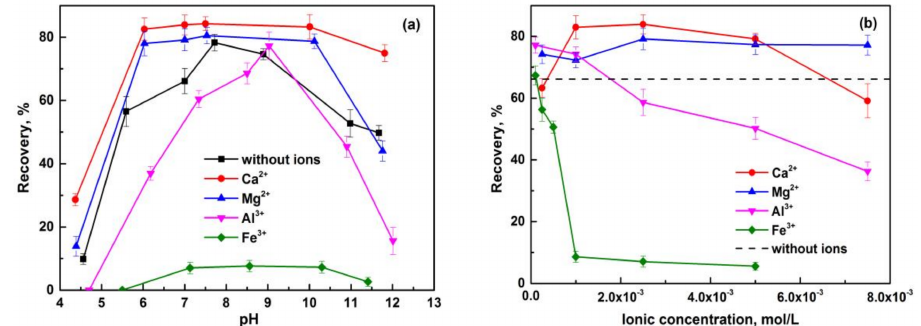
Figure 2. ( a ) Effect of pH on the floatability of apatite in the presence of metal ions at a concentration of 2.5 × 10 − 3 M; ( b ) Effect of ionic concentration on the floatability of apatite at neutral pH.